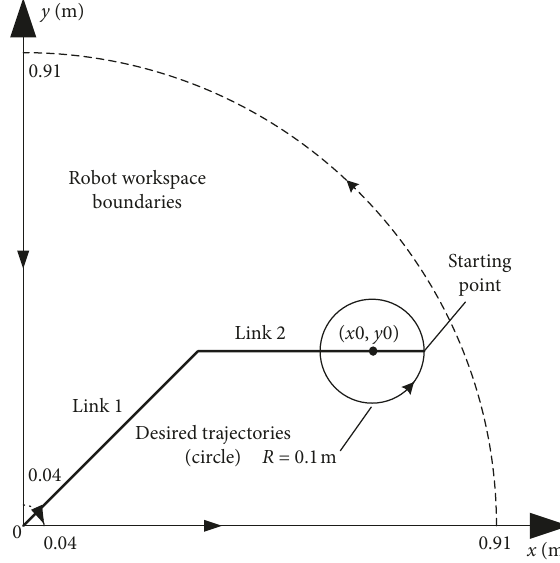
Figure 11: Reference trajectory in the workspace.